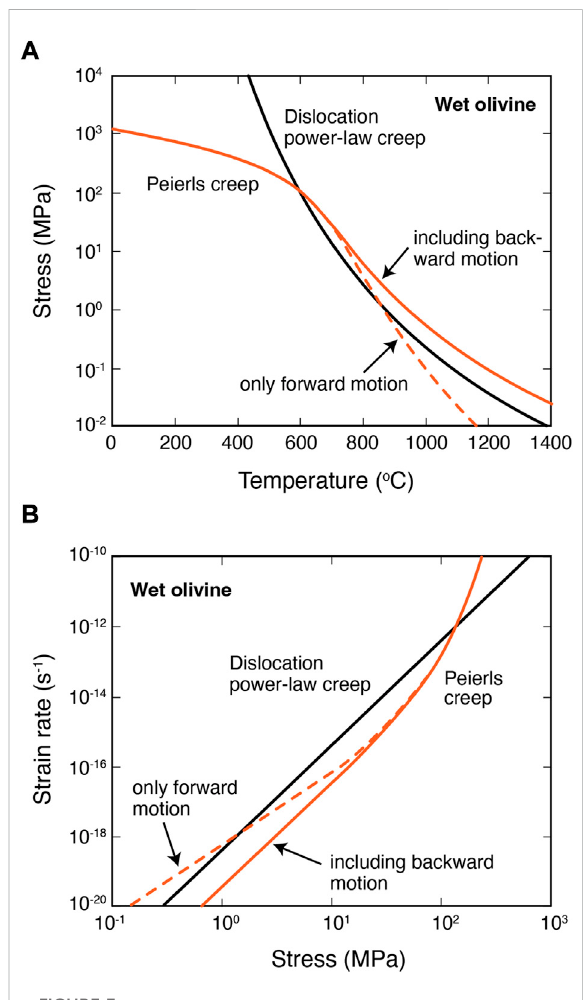
FIGURE 3 Relationship between stress and temperature for wet olivine calculated using a constant strain rate of 10 – 15 s − 1 (A) . Peierls creep dominates at low temperatures. Relationship between strain rate and stress for wet olivine calculated using a temperature of 700 ° C (B) . Calculation without backward direction results in a crossover of Peierls at low